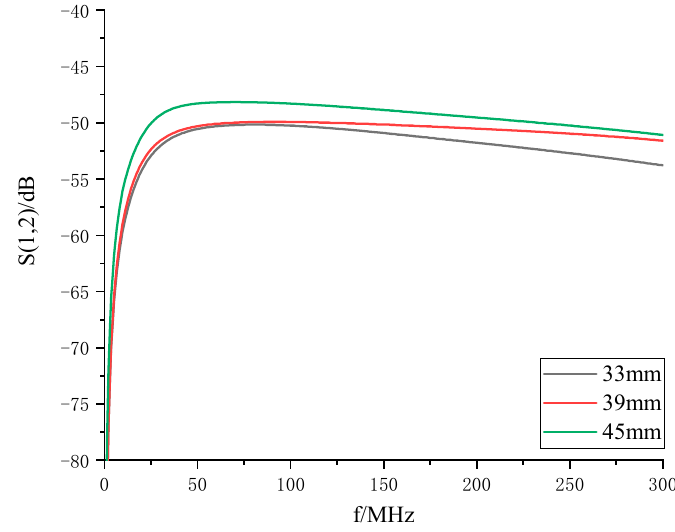
Figure 9. Frequency characteristics of the probe at different loop radius.